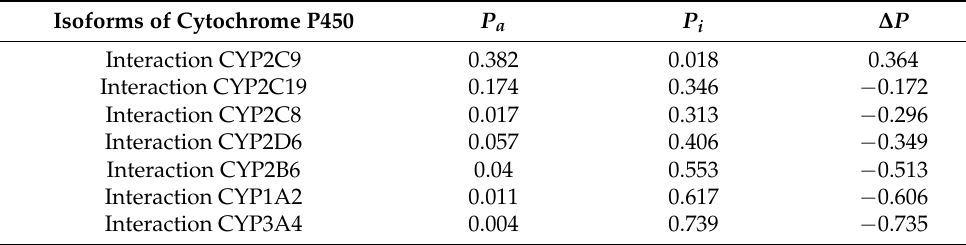
Table 3. DDI prediction for warfarin and naproxen at the level of cytochrome P450 isoforms. Isoforms of Cytochrome